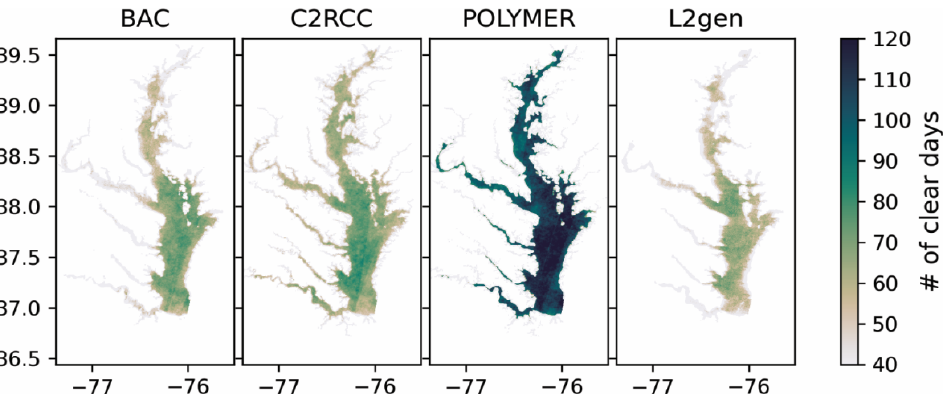
Figure 7. Number of clear (unflagged) pixels summed for 2020 for each atmospheric correction algorithm.